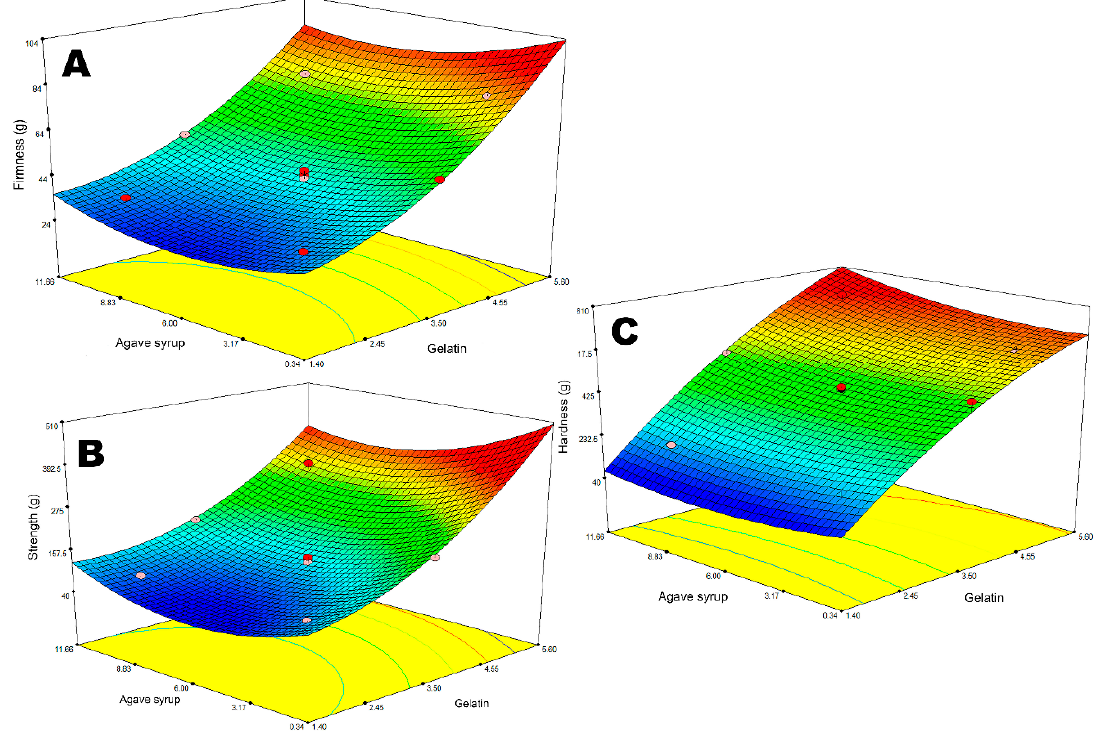
Figure 1. The influence of variables (agave syrup and gelatin) on the textural properties (firmness ( A ), strength ( B ) and hardness ( C )) of gummy bears.